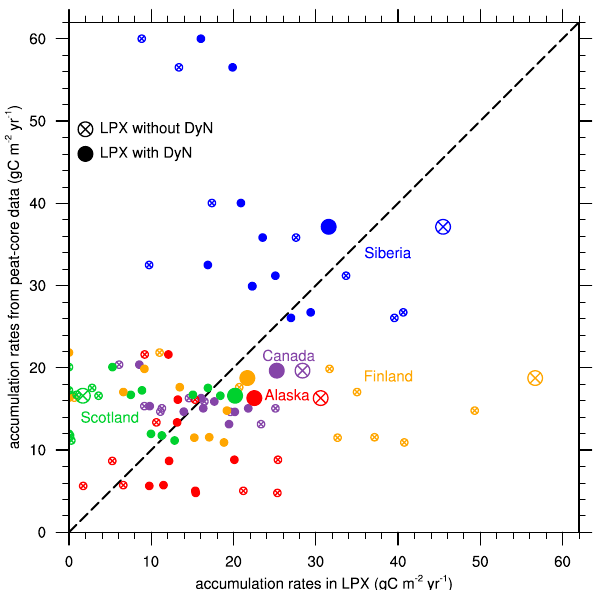
Fig. 5. Correlation of LPX simulated versus reconstructed appar- ent peat C accumulation rates averaged by region (Yu et al., 2009). Each circle represents the average of a 1000yr interval over the last 10kyr, with large circles representing the last millennium. The in- clusion of dynamic N cycle (LPX with DyN; filled circles) brings the average 1000yr apparent accumulation rates closer to the 1:1 line than the simulation results without dynamic N cycle (LPX with- out DyN; circles with cross).